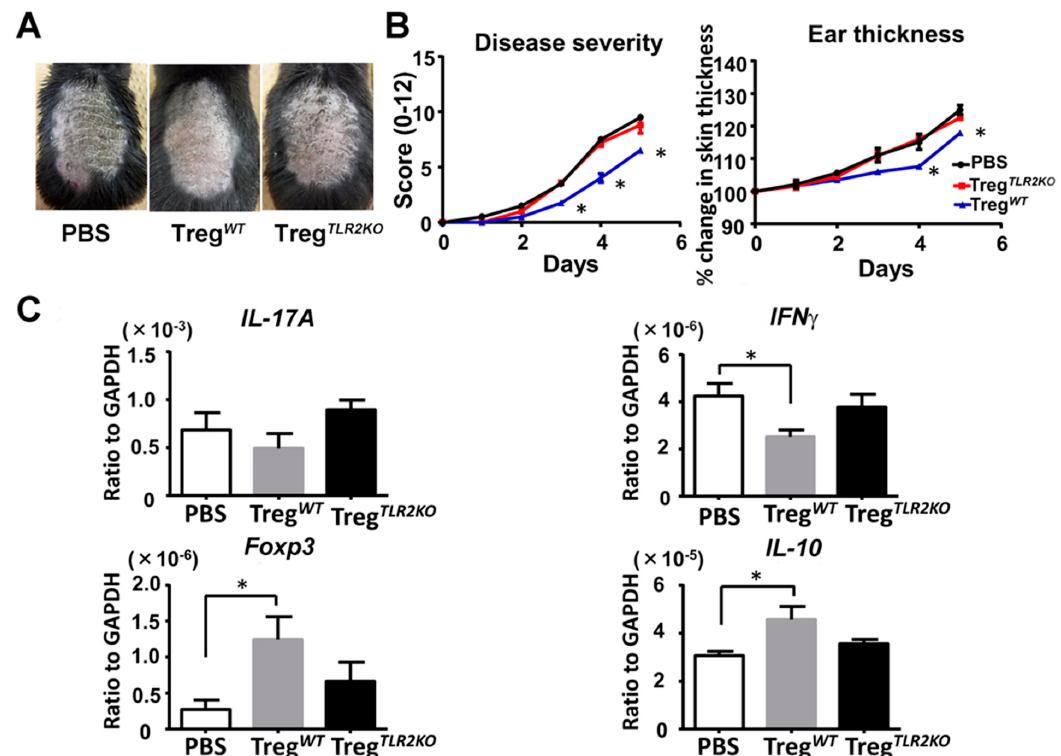
Figure 6. Adoptive transfer of Tregs from wild-type mice ameliorates imiquimod-induced psoriasiform dermatitis in TLR2-deficient mice. Shaved back skin and ears of TLR2 knockout (TLR2 KO) mice that had received Tregs from wild-type (WT) or TLR2 KO mice were topically treated with imiquimod for 5 consecutive days. ( A ) Phenotypical manifestation induced by imiquimod inTLR2 KO mouse that had received Tregs from WT mice, TLR2 KO mice, or PBS alone. ( B ) Disease severity and ear thickness during imiquimod treatment. Clinical scores for disease severity were calculated daily using a scoring system based on the clinical Psoriasis Area and Severity Index. Data are presented as mean ± SEM ( n = 6 for each group). * p < 0.05 versus PBS treatment group. ( C ) Skin samples were taken 48h after imiquimod application. Messenger RNA levels of IL-17A, IFN γ , Foxp3, and IL-10 were determined by quantitative RT-PCR. Data were obtained from duplicate samples from 6 mice in each group. Values are presented as mean ± SEM of three independent experiments. * p < 0.05.